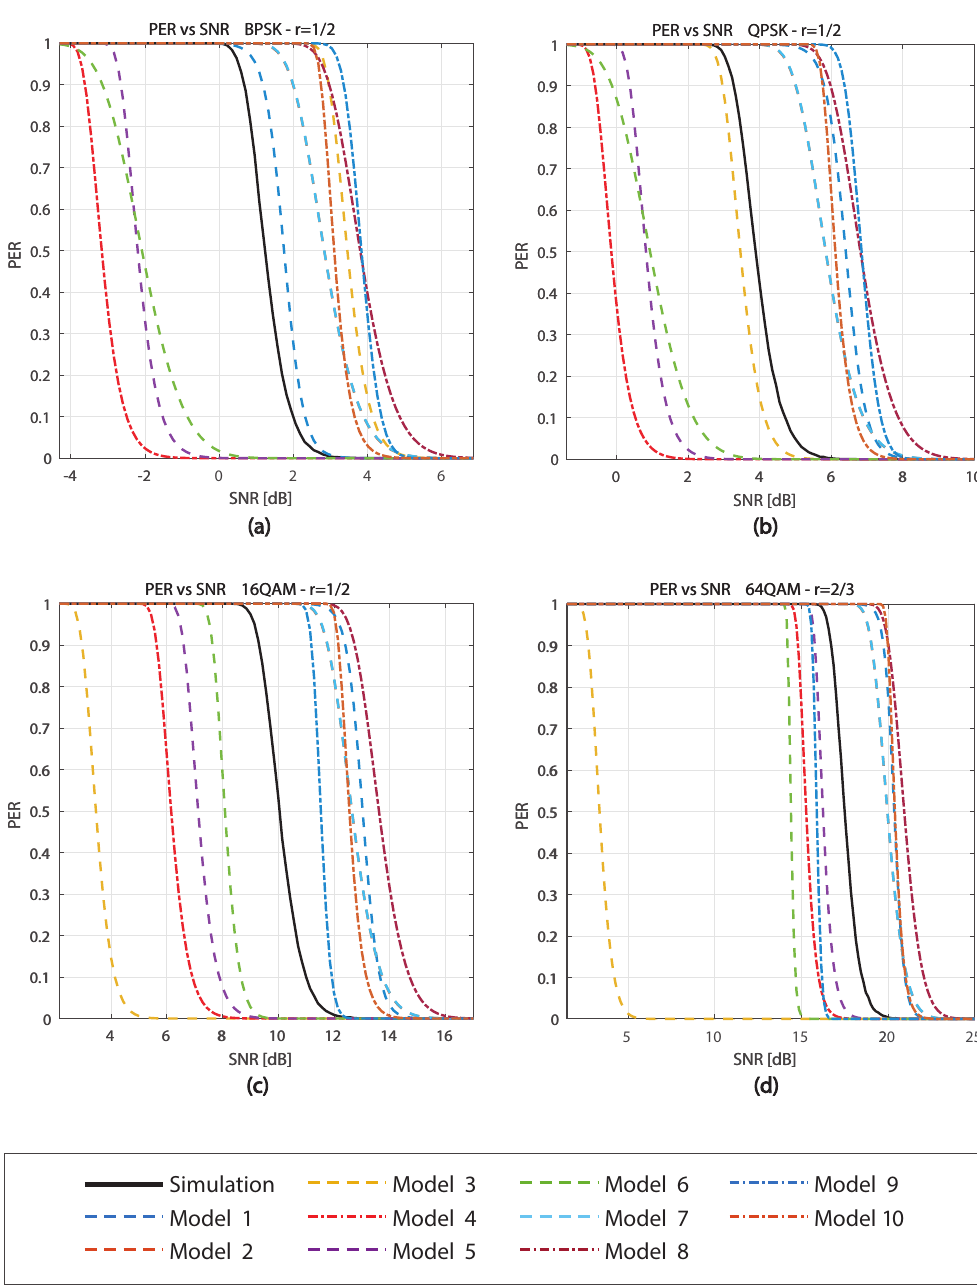
Figure 2. PER vs. SNR comparison of the models with L = 500 bytes for ( a ) 3 Mbps (BPSK R = 1/2), ( b ) 6 Mbps (QPSK R = 1/2), ( c ) 12 Mbps (16QAM R = 1/2), ( d ) 24 Mbps (64QAM R =